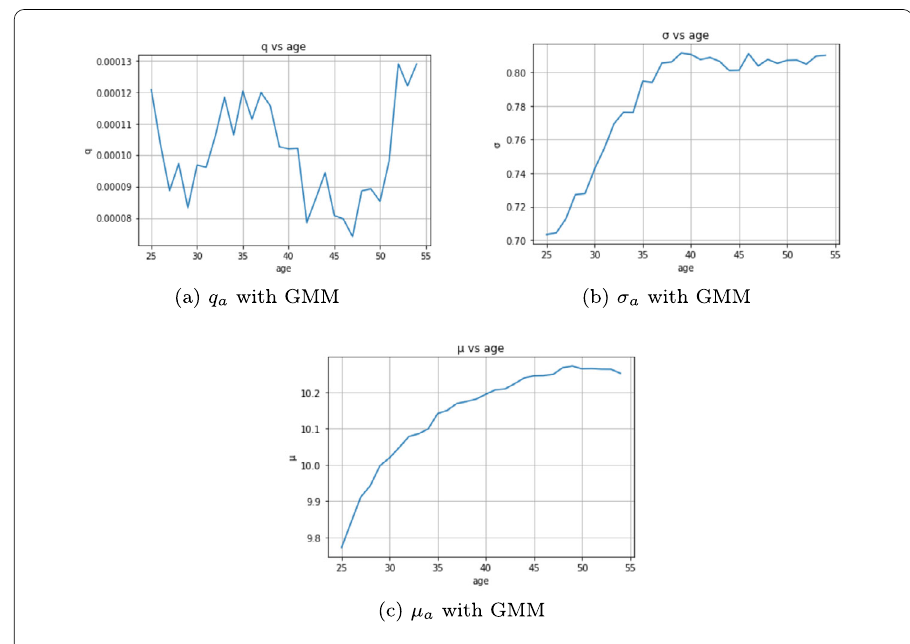
Figure 11 q a , σ a and μ a Plots for USA Labour Income